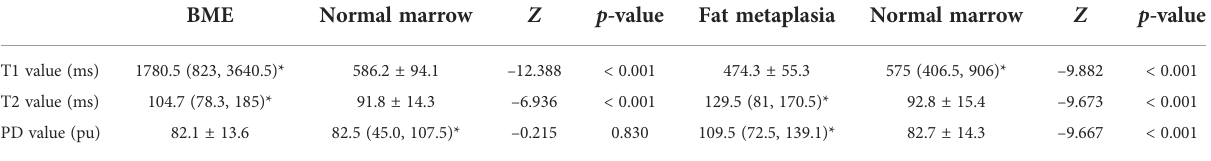
TABLE 4 T1, T2, PD values of BME, fat metaplasia, and normal